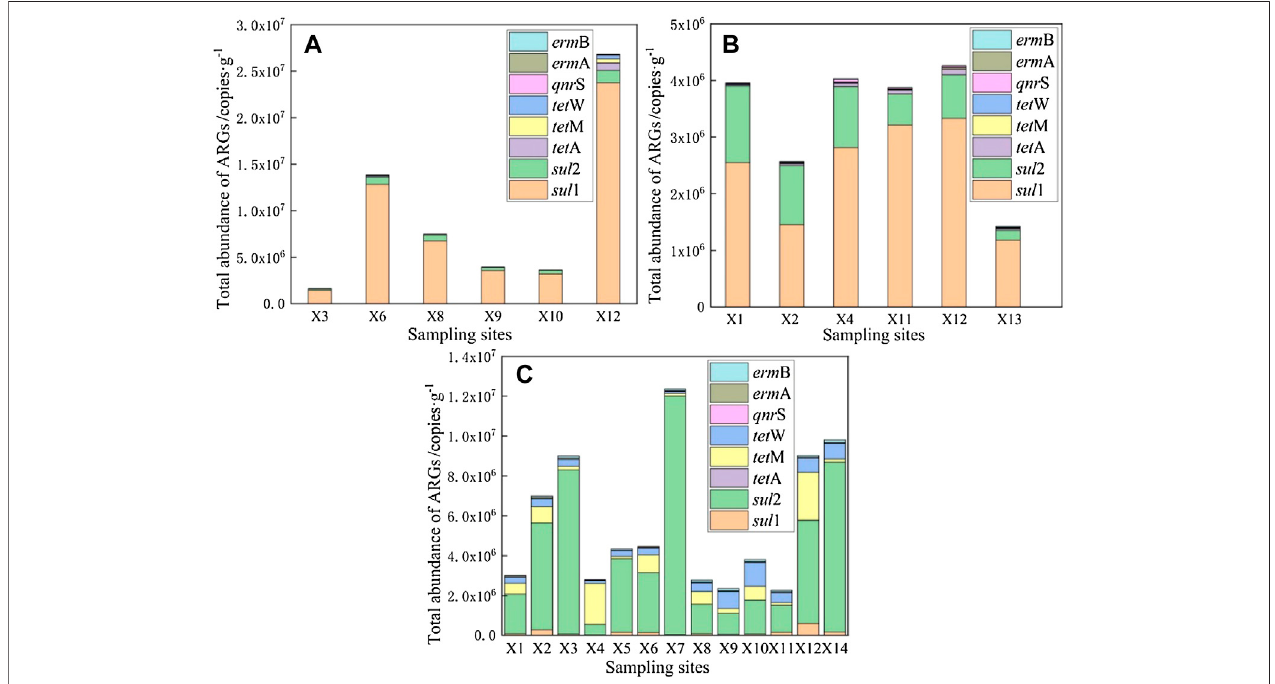
FIGURE 9 | Total abundance of ARGs in surface sediments of East Dongting Lake in spring (A) , summer (B) , and fall (C) .